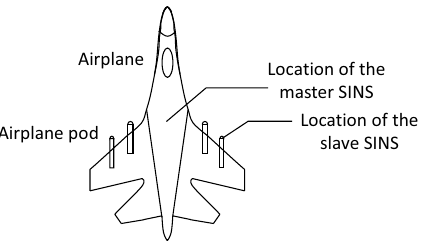
Figure 1. The schematic diagram of master SINS and slave